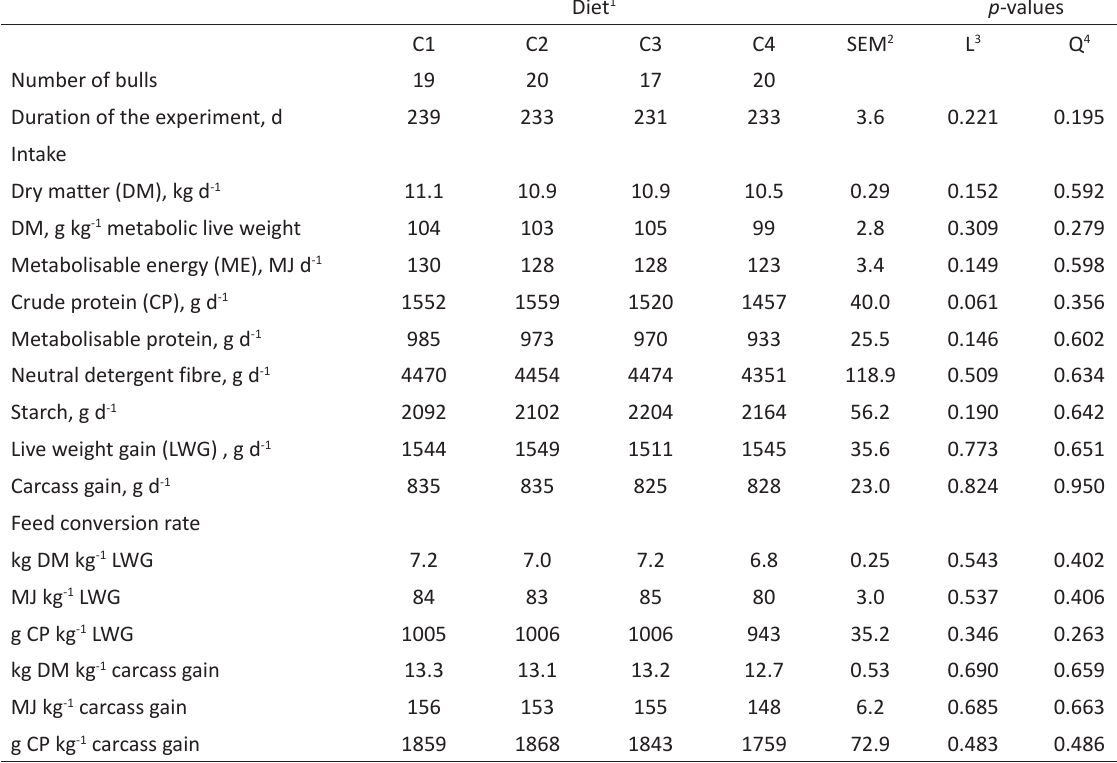
Table 2. Intake, growth performance and feed conversion of the bulls